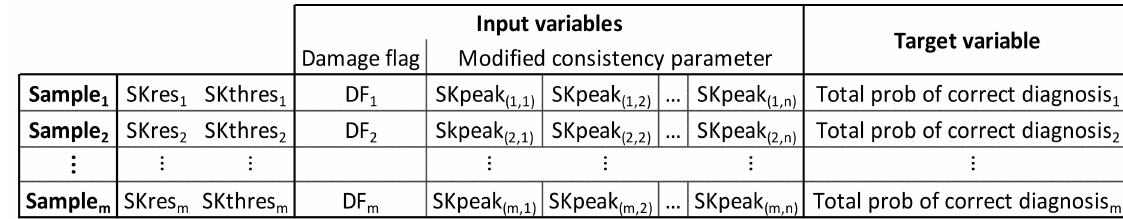
Figure 3. Example of machine learning variables, when using the novel consistency vector, related to SK peaks. The damage flag (DF) is a 0 or 1 value to denote if the sample was from an SKres and SKthres applied to a damaged or undamaged data